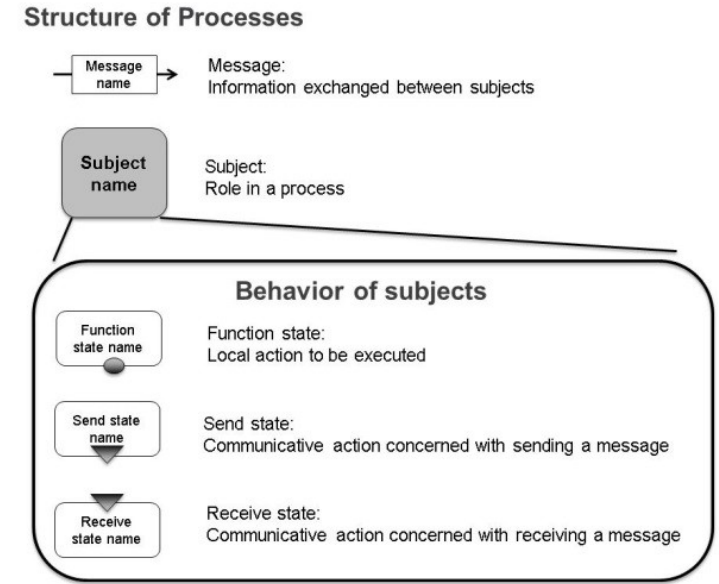
Figure 4. Standard set of symbols in Subject-oriented